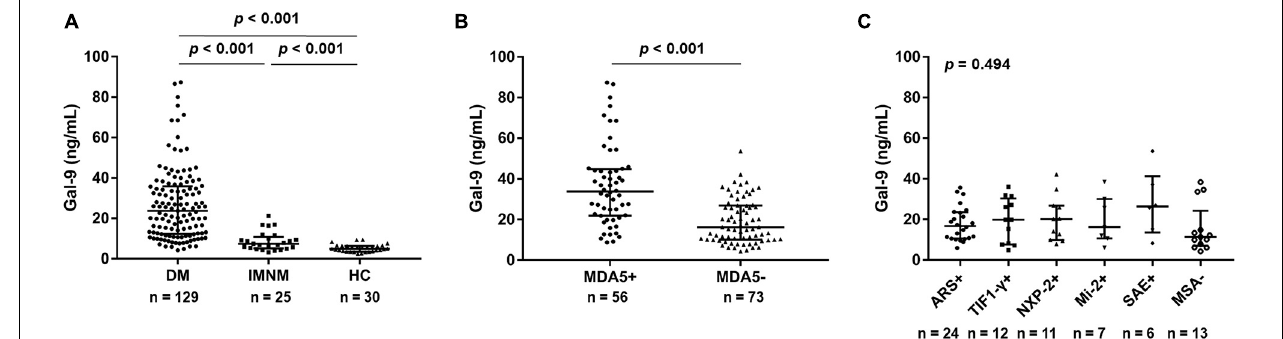
FIGURE 1 | Serum galectin-9 (Gal-9) levels in patients with idiopathic inflammatory myopathies and healthy controls (HCs). (A) Patients with dermatomyositis (DM), patients with immune-mediated necrotizing myopathy (IMNM), and HCs. (B) Patients with DM divided into anti-melanoma differentiation-associated gene 5 (MDA5)-positive group and anti-MDA5-negative group. (C) Anti-MDA5-negative patients stratified by myositis-specific antibodies (MSAs). ARS: aminoacyl-tRN synthetase; TIF1- γ : transcriptional intermediary factor 1 γ ; NXP-2: nuclear matrix protein 2; SAE: small ubiquitin-like modifier activating enzyme. Horizontal bars indicate median with interquartile